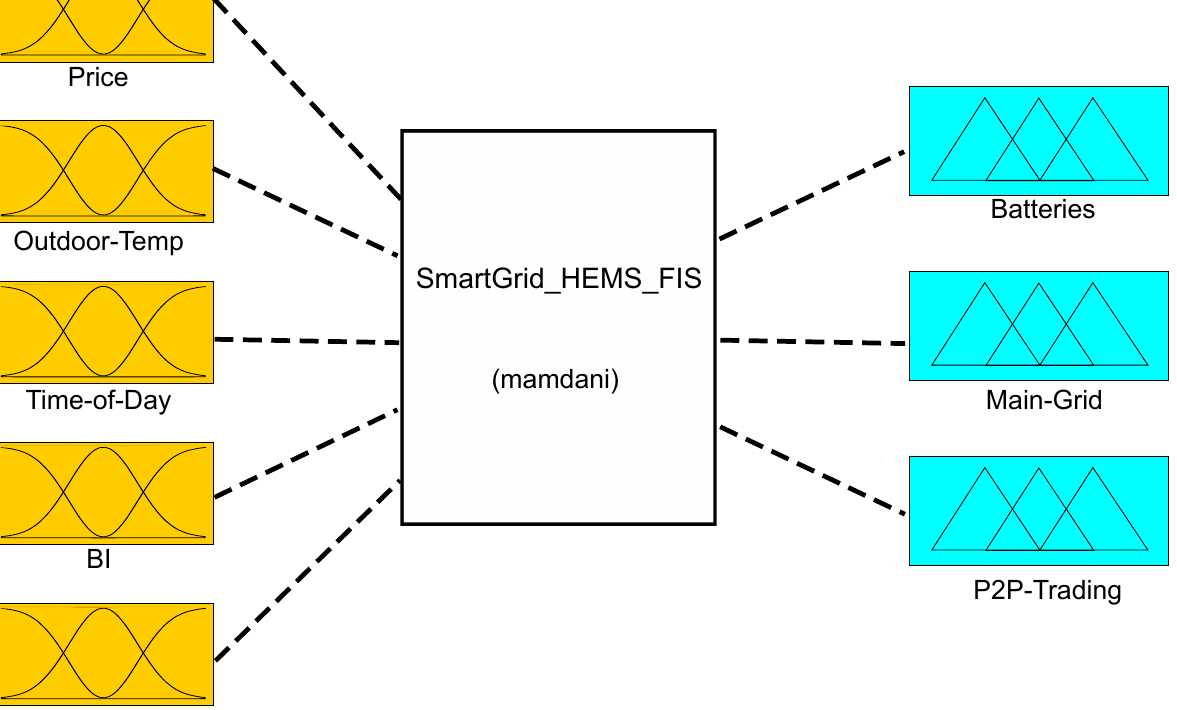
Figure 6. Higher-level representation of our proposed fuzzy inference system (FIS) in the fuzzy logic toolbox of